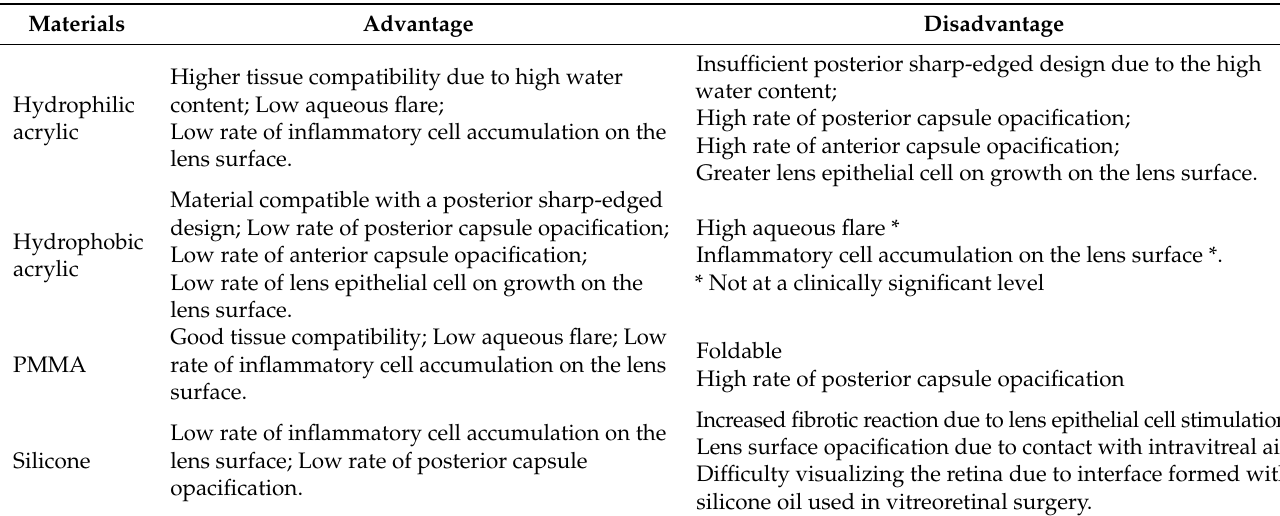
Table 6. Comparison of biocompatibility of IOL materials. Reprinted with permission from Ref.